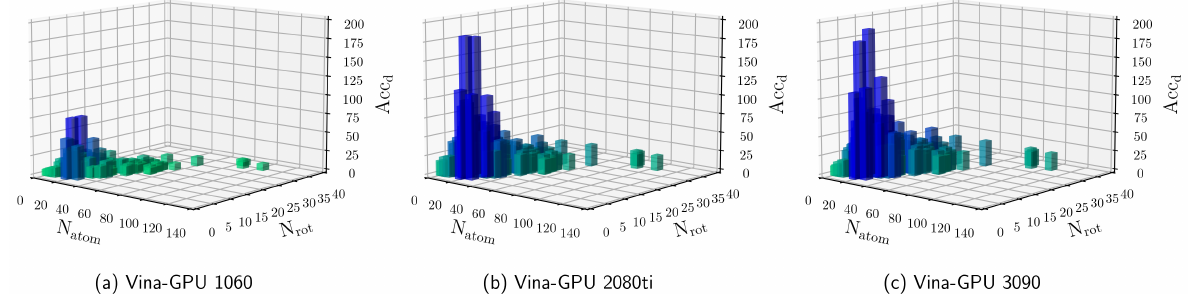
Figure 9. Details for the acceleration of docking time ( Acc d ) of our Vina-GPU against AutoDock Vina on all 140 complexes. The complexity is depicted with their number of atoms ( N atom ) and rotatable bonds ( N rot ). The vertical axis ranges from 0 to 210, and each bar represents a complex coupling with its corresponding acceleration ratio. Vina-GPU 1080ti, Vina-GPU 2080ti and Vina-GPU 3090 mean that Vina-GPU was executed on Nvidia Geforce GTX 1080ti, Nvidia Geforce RTX 2080Ti and Nvidia Geforce RTX 3090, respectively. The color depth of each bar indicates the value of accelerations (the darker the